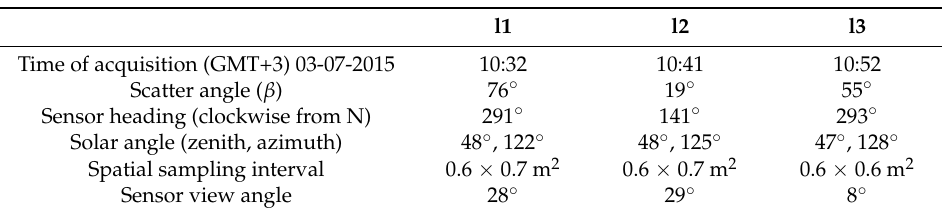
Table 2. Sensor specifications and configuration during acquisitions.